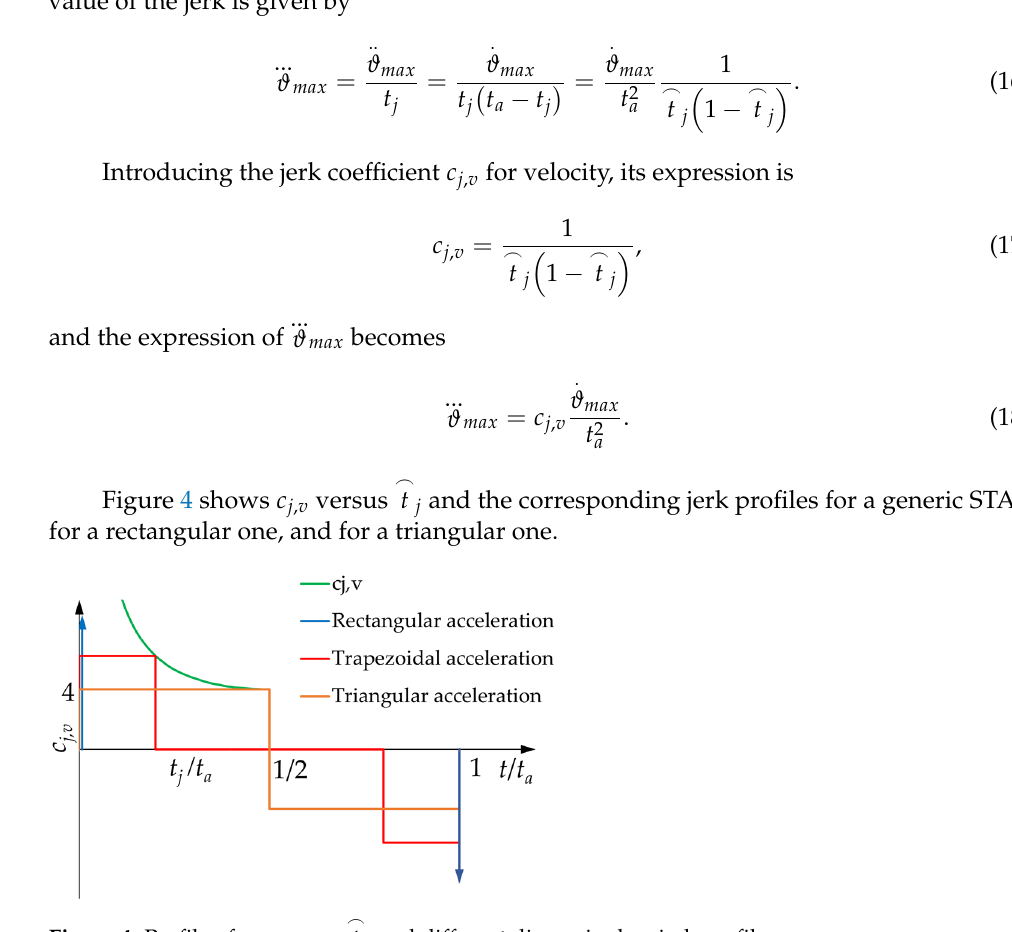
Figure 4. Profile of c j , v versus